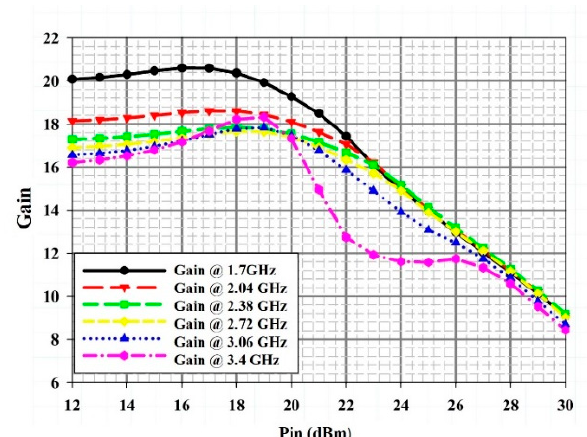
Figure 19. Measured Gain (dB) versus P in (dBm) for the Doherty Amplifier in Figure 16.